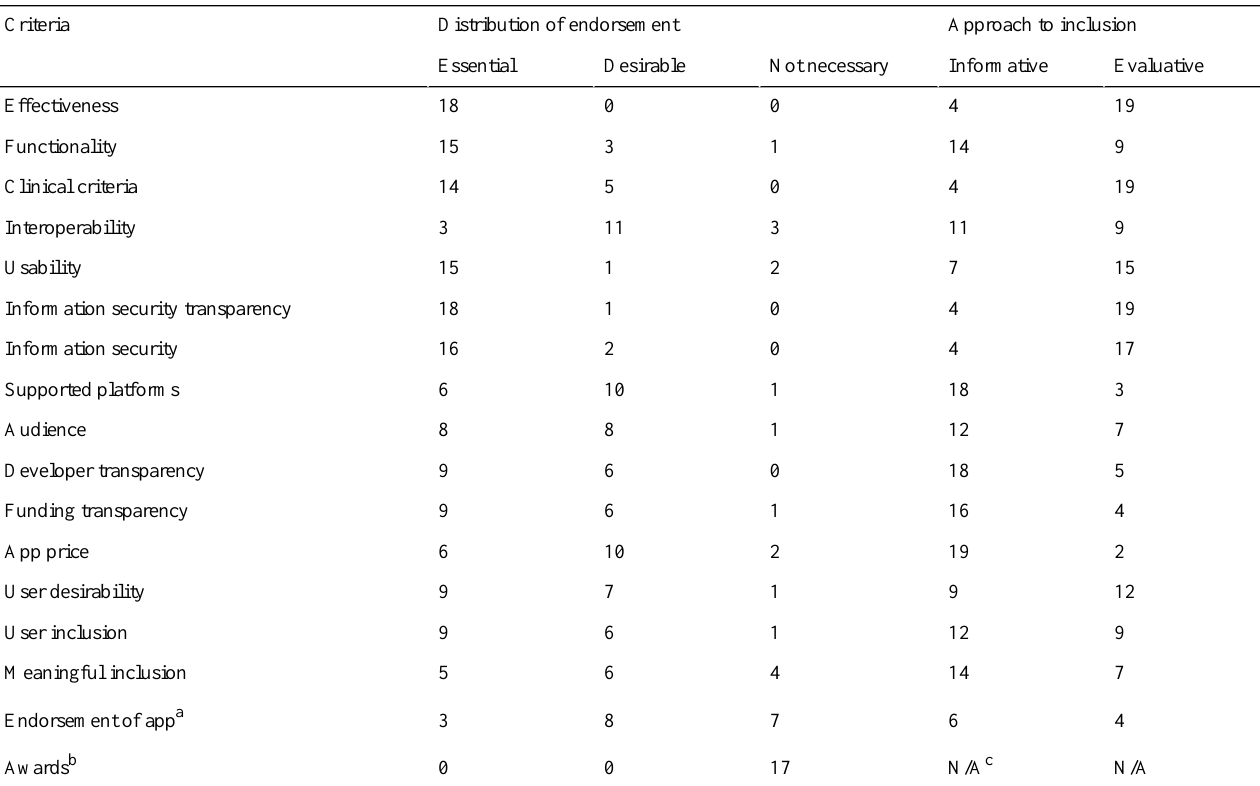
Table 1. Round 2 criteria voting results.